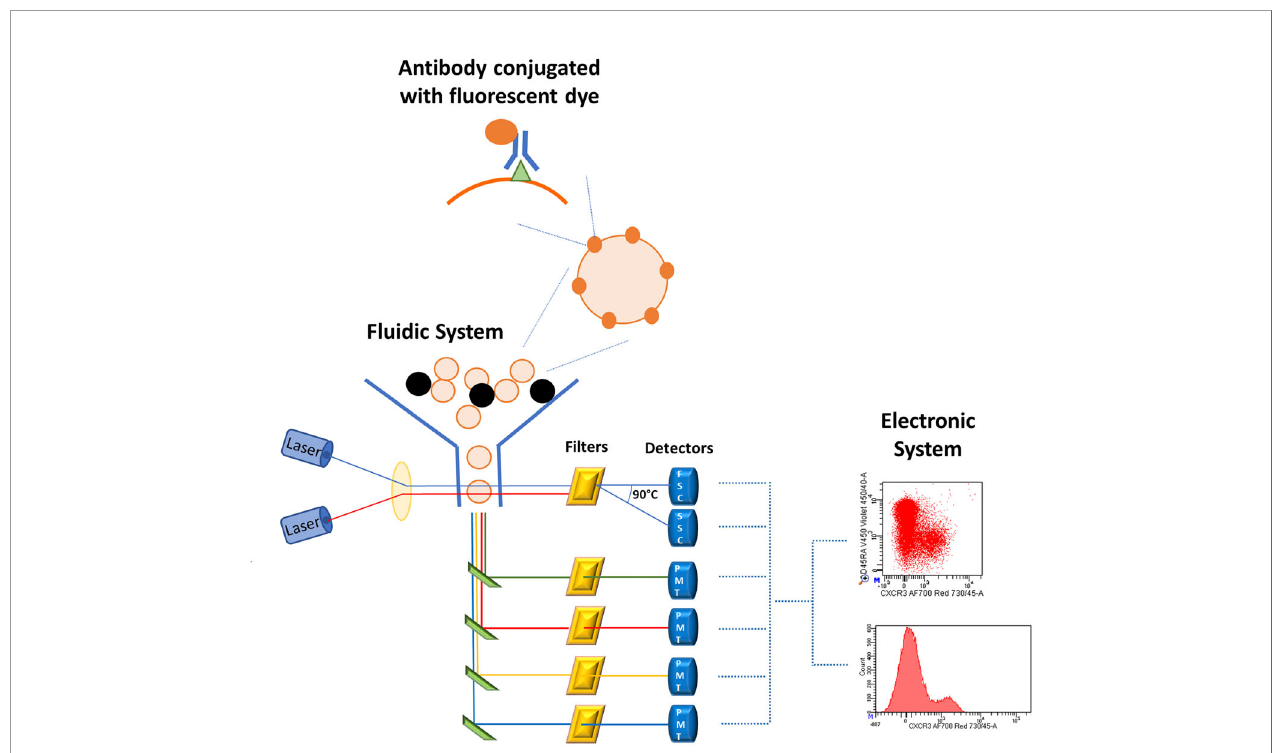
FIGURE 2 | Schematic representation of fl ow cytometry system. Cells stained with fl uorescent-conjugated antibodies are aligned in the fl uidic system where they encounter one or more laser beams which excite the fl uorescent dyes bound to the cells. The fl uorescent antibodies emit at a speci fi c wavelength and the emission is proportional to the amount of antigen-antibody complex. The emission arrives to the optical system, consisting of fi lters, mirrors, and photomultiplier tubes (PMTs), which enhance and improve the signal. Finally, the electronic system converts the fl uorescent emission in electronic signals visualized by histograms or bi-dimensional